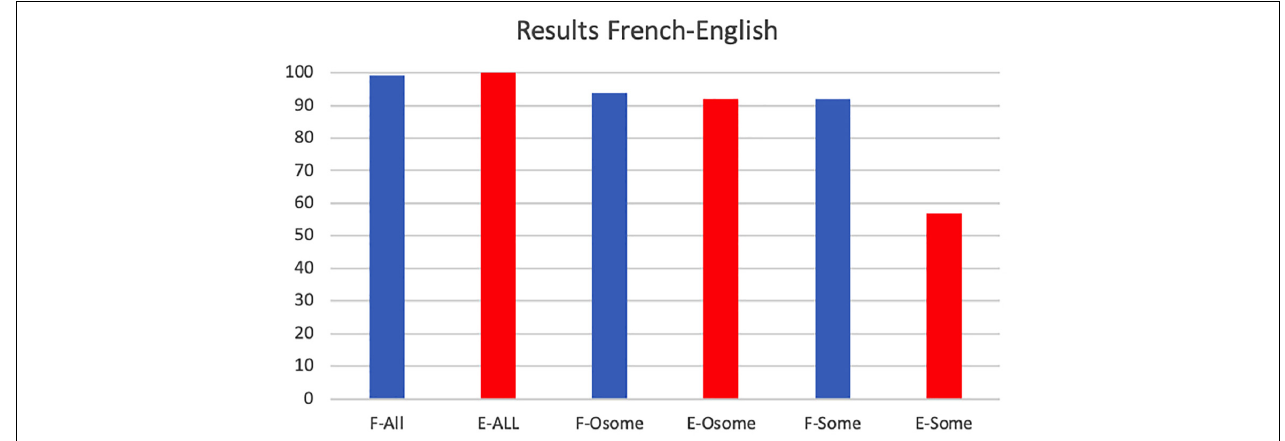
FIGURE 11 | Experiment 2: Response rates when choosing a pragmatic answer by French (blue) and English (red) participants (E, English; F, French; All, the all condition; Osome, the only some condition; Some , the some condition).